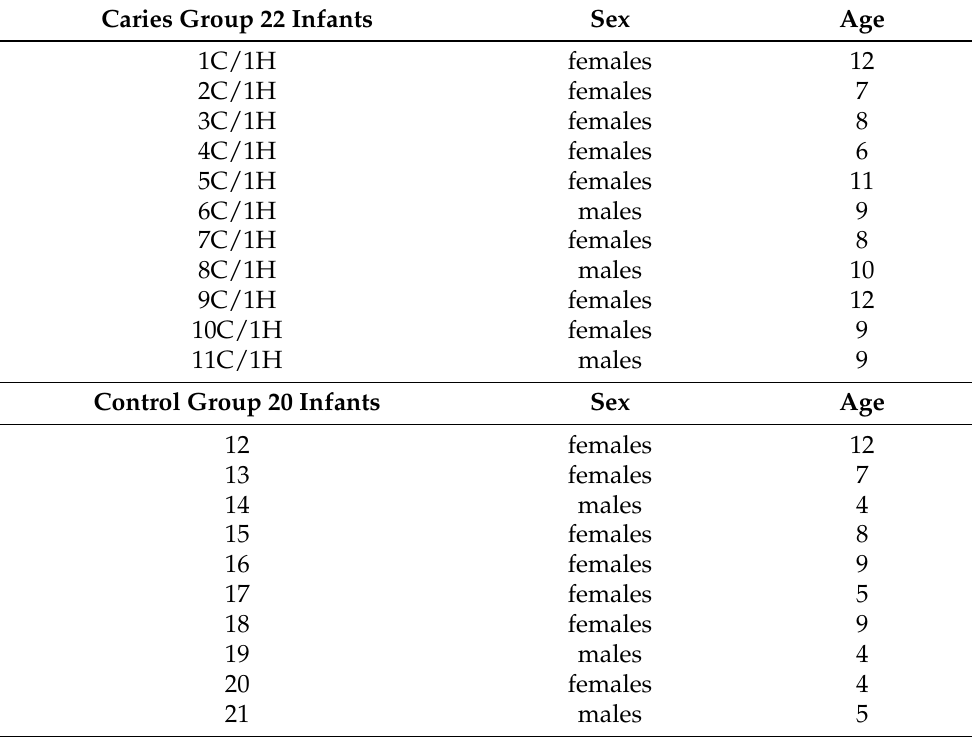
Table 1. Main characteristics of the 42 participants. C, caries; H,